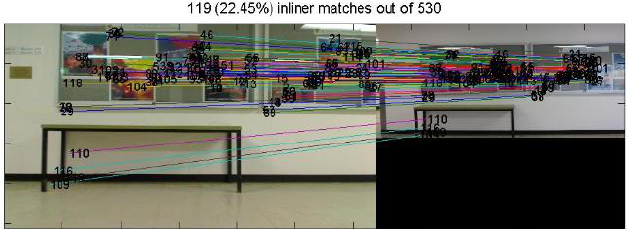
Figure 16. Matching between real time query image No. 64 and geo-referenced map image.